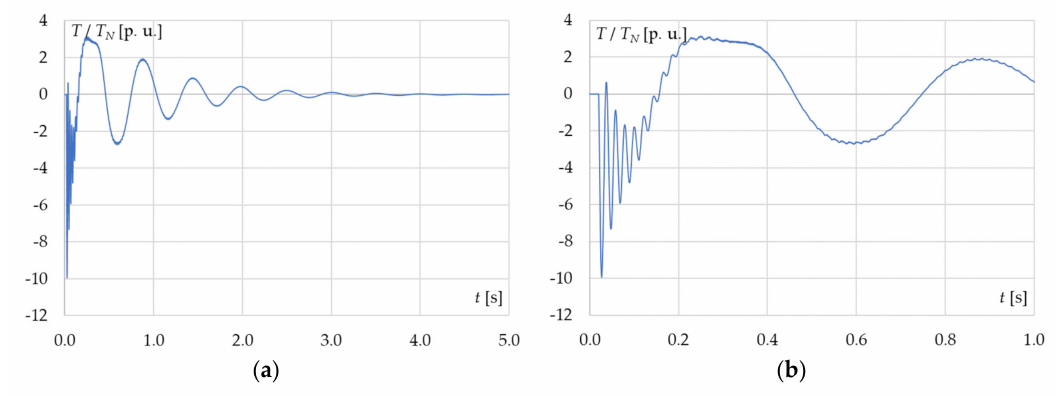
Figure 13. Waveform of electromagnetic torque during out-of-phase synchronization of − 120 ◦ in ( a ) the scope of the considered calculation time and ( b ) the first second.